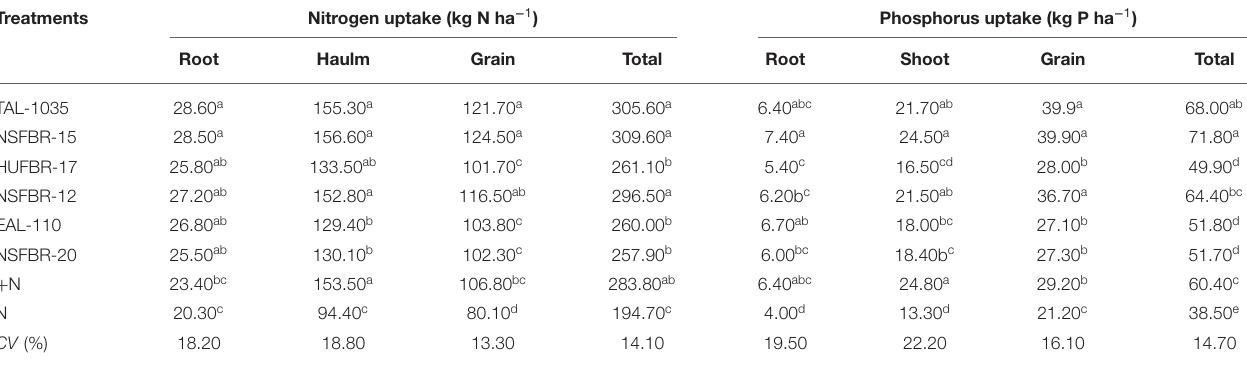
TABLE 4 | The nitrogen and phosphorus uptaking by roots, haulms, and grains of faba bean inoculated with six different Rhizobium strains.